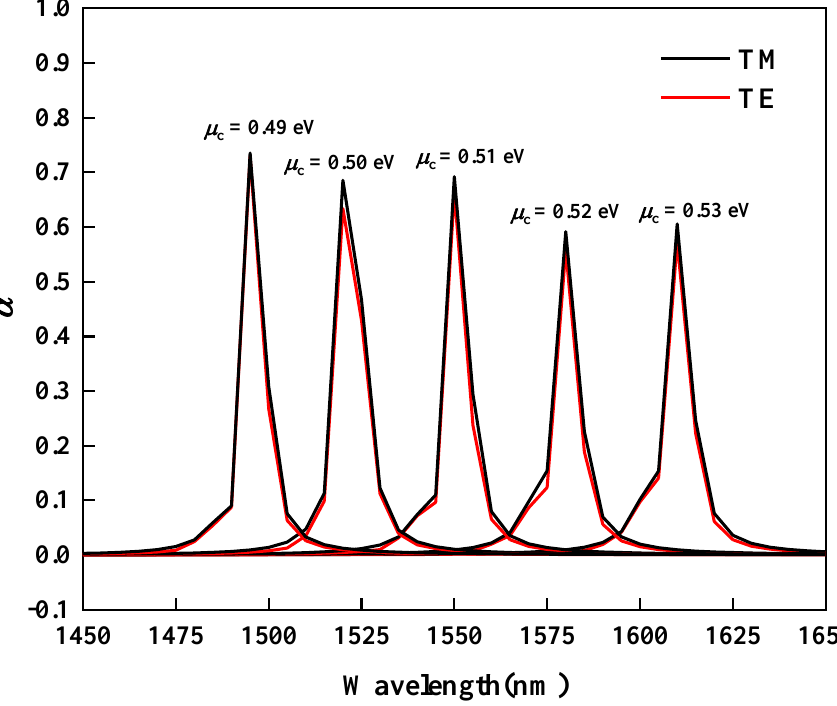
Figure 6. When µ c is equal to 0.49 eV, 0.50 eV, 0.51 eV, 0.52 eV, 0.53 eV, the variation of the imaginary part of effective refractive index for both TE and TM modes at different wavelength.